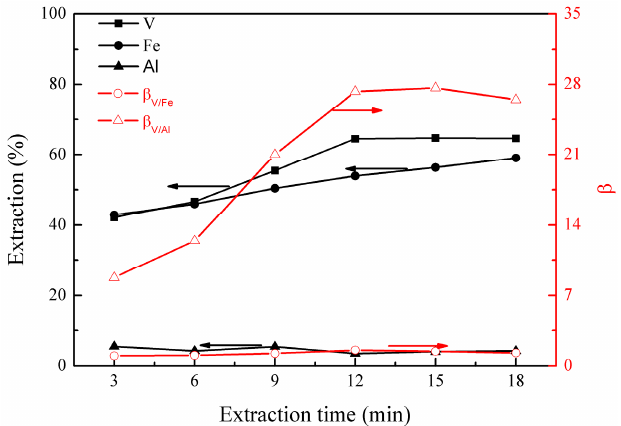
Figure 3. Effect of extraction time on the extraction percentages of V (IV), Fe, and Al, as well as on the separation factors β V/Fe and β V/Al .